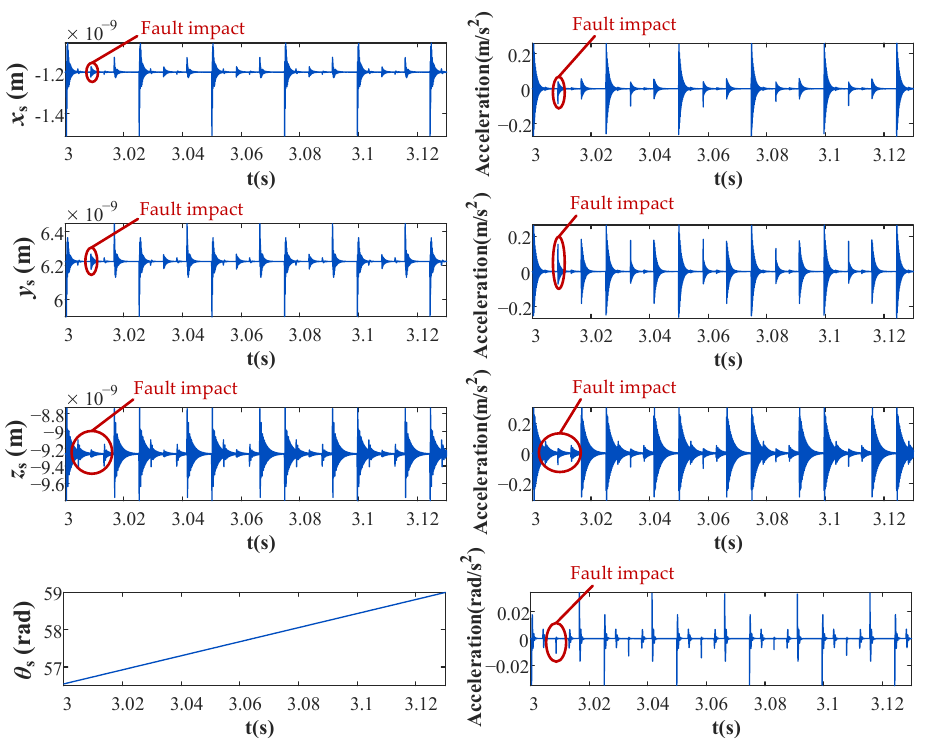
Figure 10. Displacement responses and acceleration responses of the screw-shaft-related parameters under faulty conditions. Actuators 2022 , 11 , 226 Fast Fourier transform (FFT) is then applied to the acceleration responses to acquire the frequency spectra of the normal and fault models. Figure 12 shows the acceleration spectra of the screw-shaft-related parameters under normal and fault conditions. The ball passage frequency ( f b ), which is at about 40.29 Hz, can be observed in the normal fre- quency spectra. The harmonics of the ball passage frequency can also be found in the spectra. In the fault spectrum, the positions of f b and each of its harmonics are roughly the same as those in the normal spectra, despite the change in amplitude. After the spalling fault occurs, the amplitude at the first and second harmonics of f b decrease, whereas the amplitude at the third harmonic increases. This phenomenon can also be observed in the frequency spectra of nut-related parameters, as shown in Figure 13. This is because when the spalling fault occurs, the number of impacts in the same ball passage cycle changes from two to three, resulting in an increase in the amplitude at the third harmonic of f b in the frequency spectra obtained by FFT and a decrease at the first and second harmonics of f b .